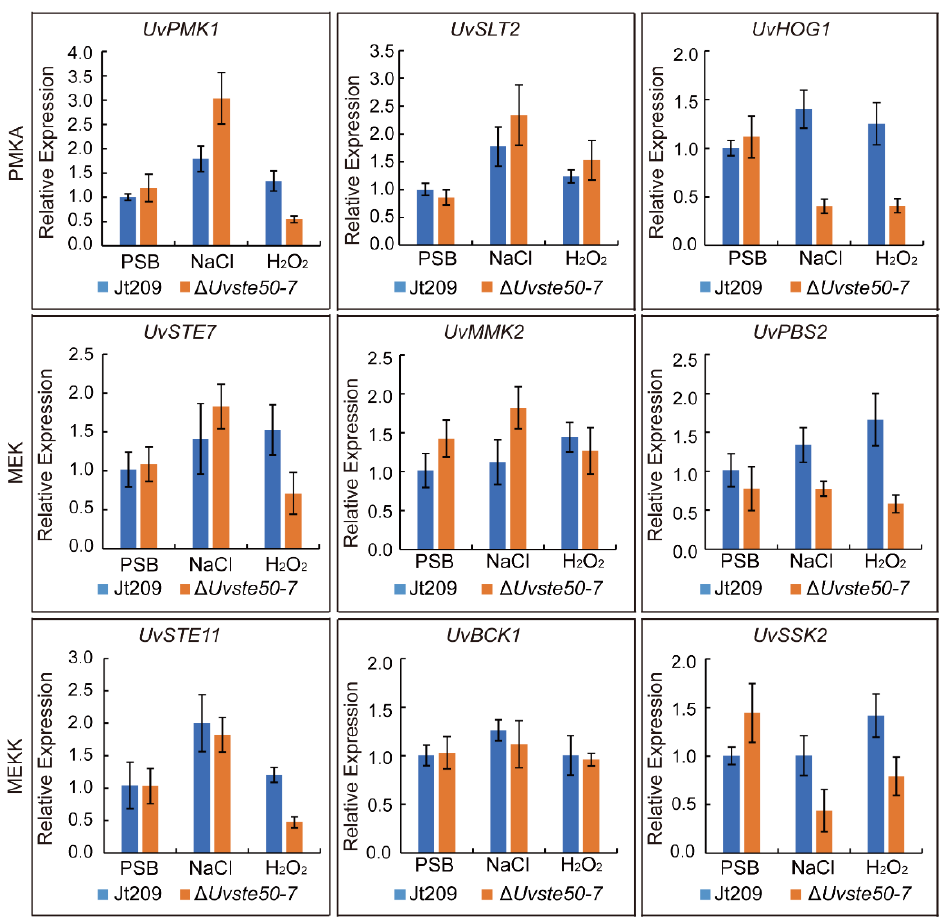
Figure 7. Expression profiles of genes involved in MAPK signaling pathways. RNA samples were isolated from vegetative hyphae of the wild ‐ type strain Jt209 and the Δ Uvste50 mutant cultured in regular PSB or PSB with 0.5 M NaCl or 0.05% H 2 O 2 . The expression level of each gene in the wild ‐ type strain Jt209 cultured in regular PSB was arbitrarily set to 1.0. Mean and standard deviations were calculated considering the results of three independent